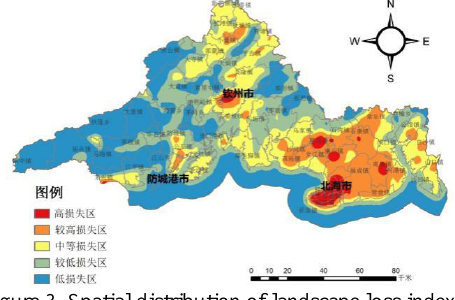
Figure 3. Spatial distribution of landscape loss index in Guangxi Coastal Zone in